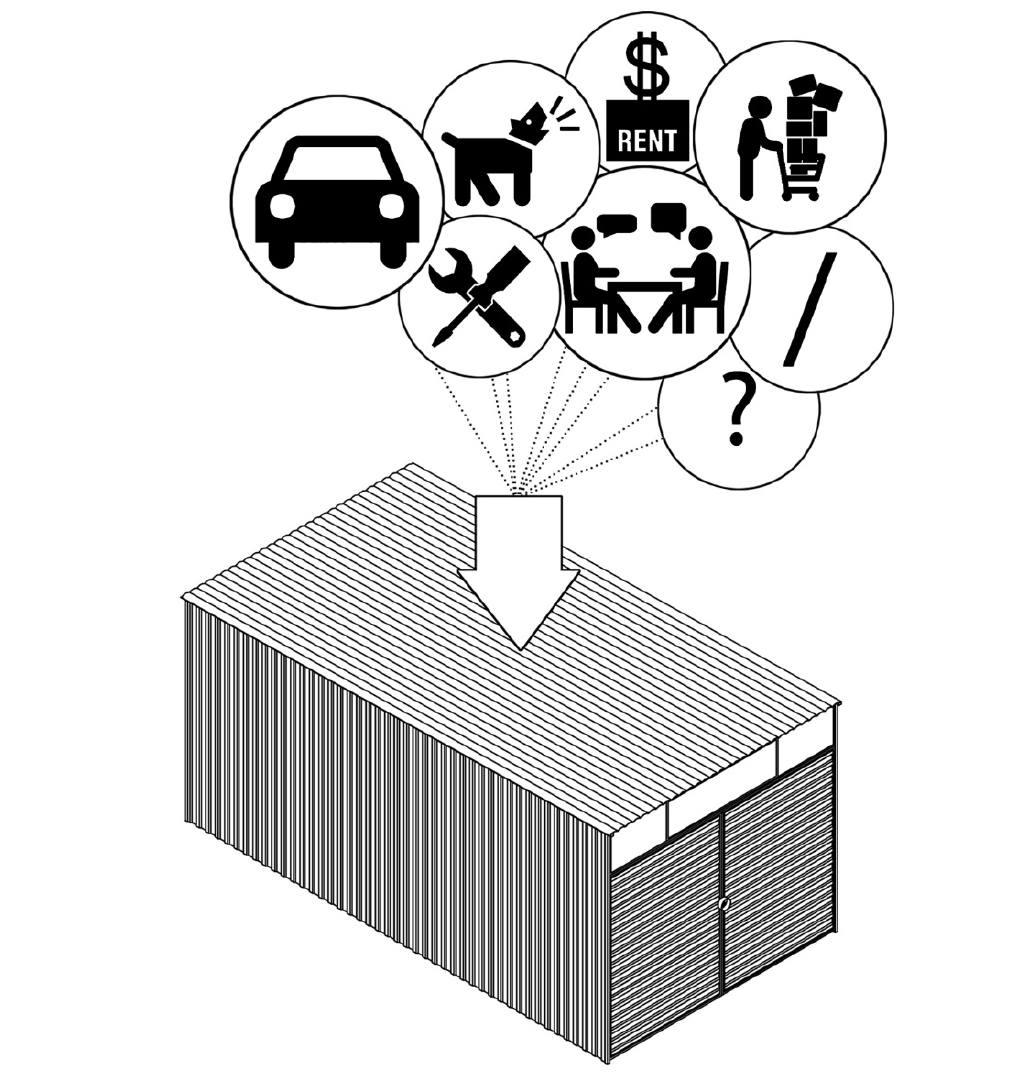
Figure 10: What is the